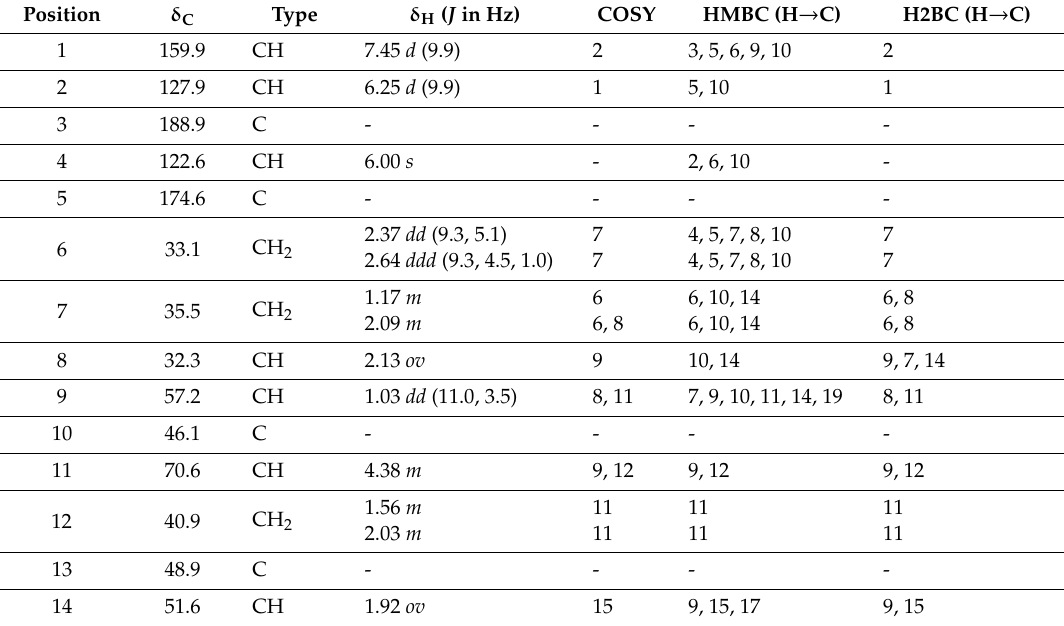
Table 1. 1D and 2D NMR data of 16 α -OH-prednisolone in CD 3